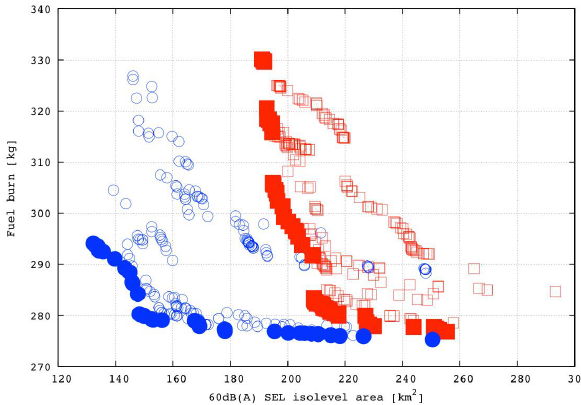
Figure 9: Effect of the low-noise technologies on the Pareto front of the fuel/noise multi-objective optimization (twin-engine, mid-range